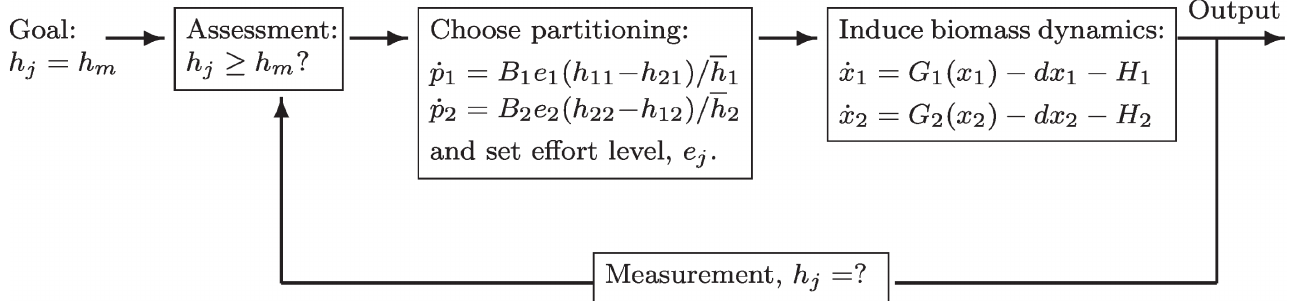
Fig 2. Basic block, feedback diagram of the SPDm. Equations defined in the Model and methods section. The diagram reads as follows: The goal is set outside the loop, and enters from the left. The feedback loop iterates as individuals assess whether the goal is met. Foragers adjust their effort and spatial partitioning, which affects biophysical dynamics and produces an output (harvest). Foragers then measure (do I feel hungry) and compare the harvest with their goal in the next time period.